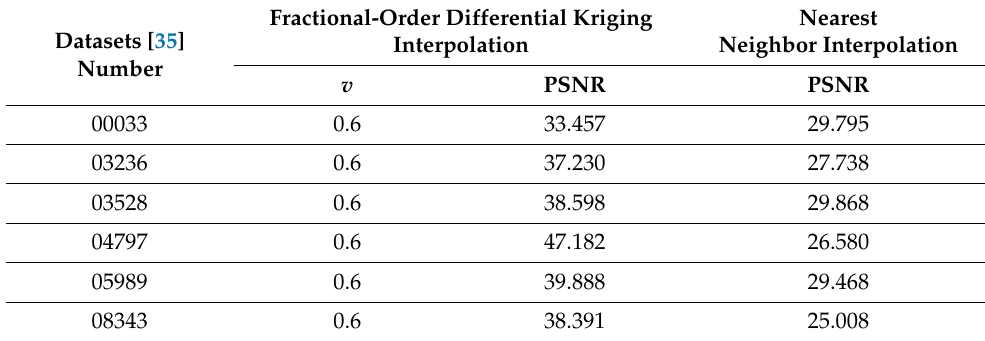
Table 2. Fractional-order differential Kriging interpolation super-resolution (200%).